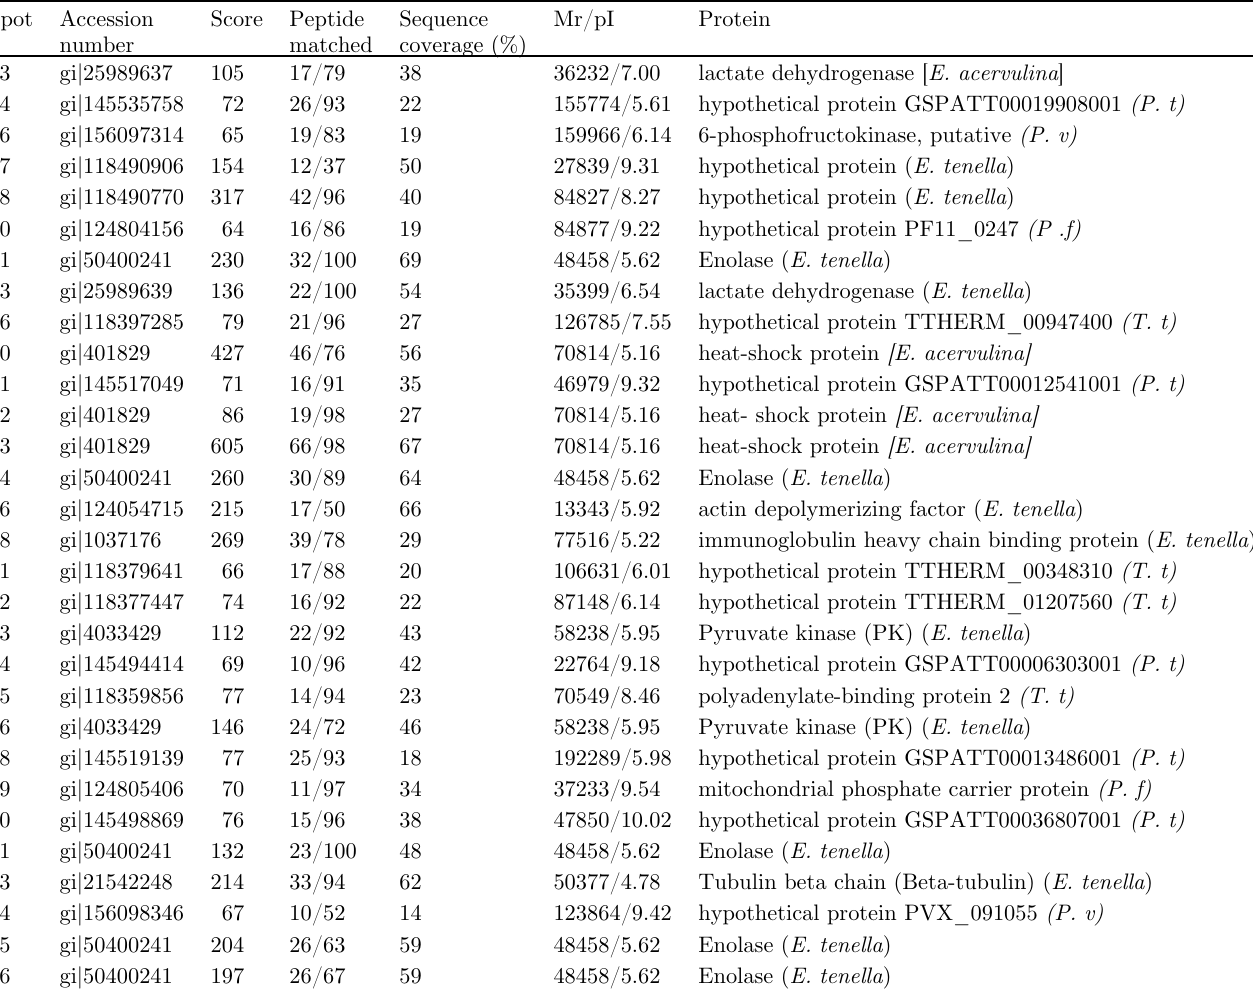
Table 1. Identi fi cation of unsporulated Eimeria tenella oocyst proteins in non-redundant sequence databases (NCBI) using data from MALDI-TOF-MS and